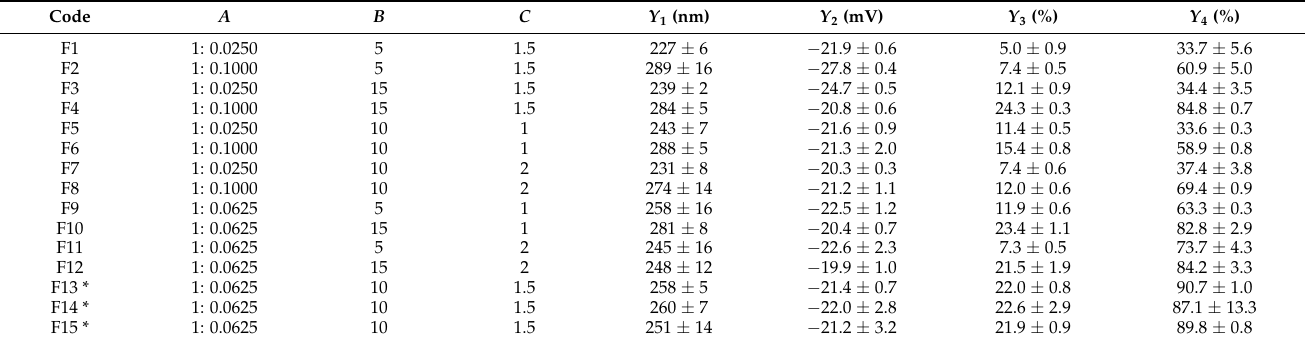
Table 2. BBD experimental matrix and response values for the optimization of